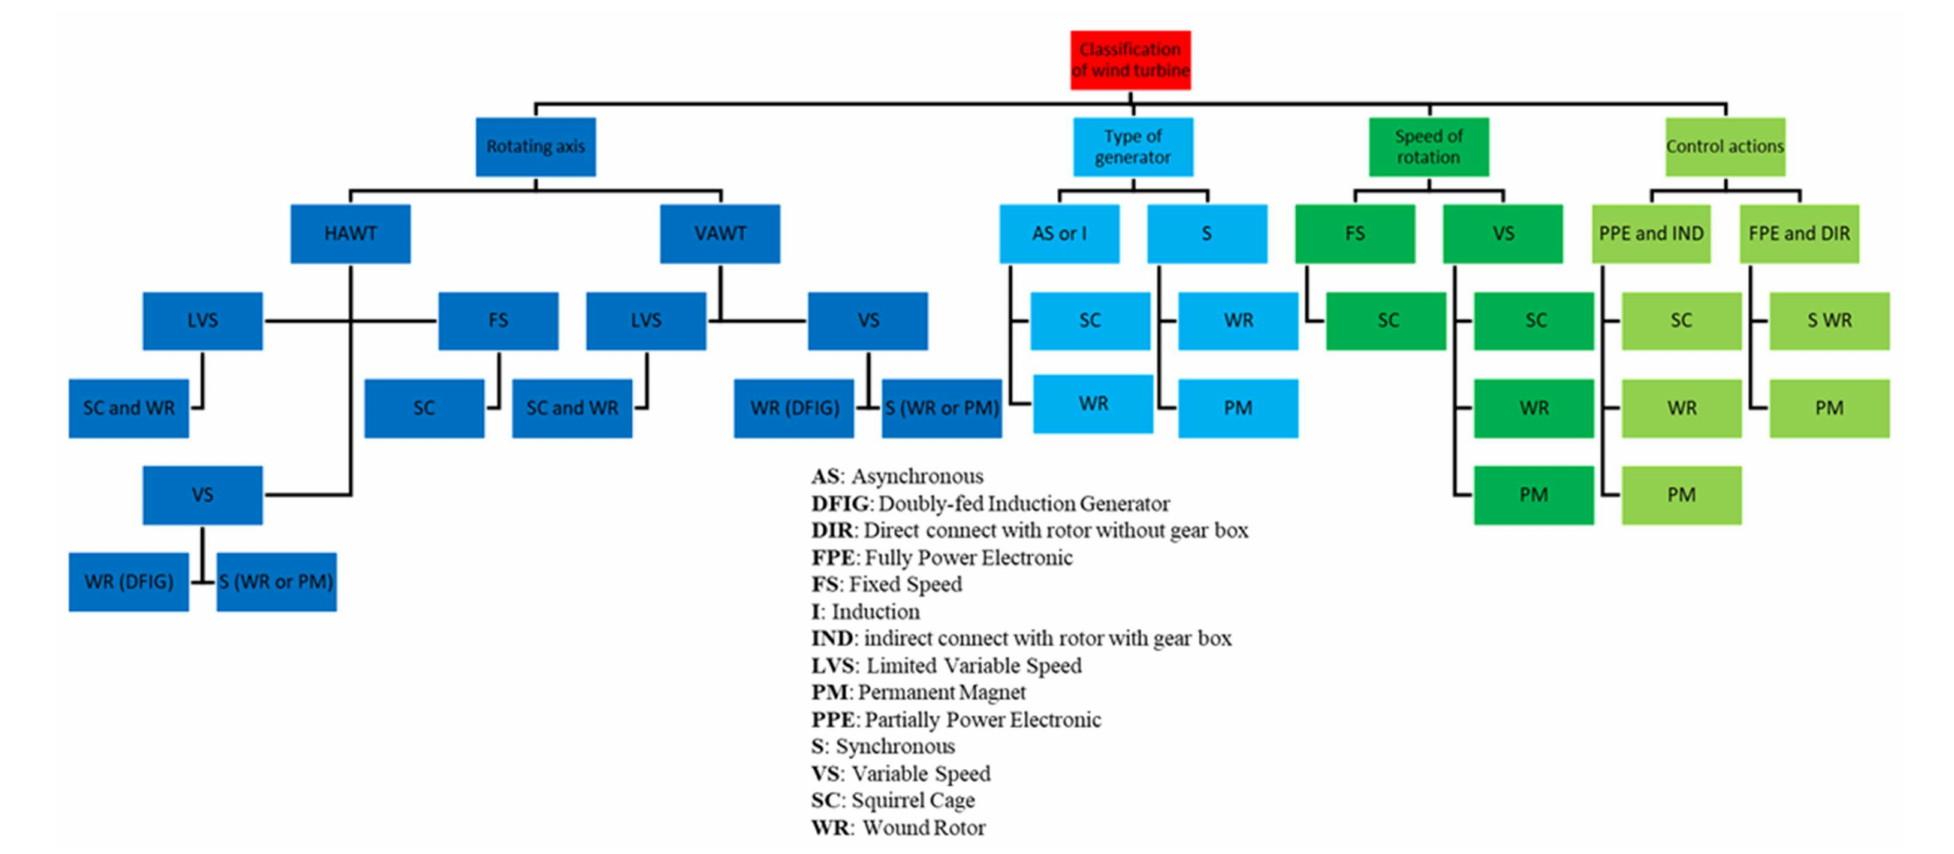
Figure 5. Classifications of wind